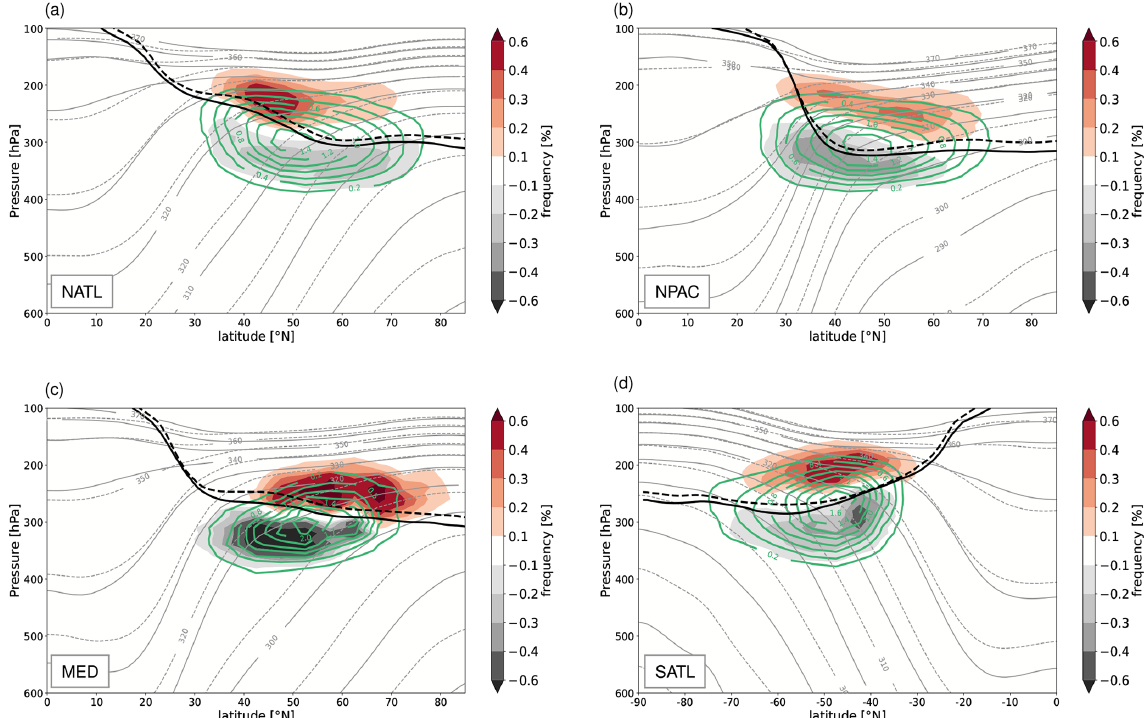
Figure 11. The 50-year mean potential temperature (grey lines) and potential vorticity (2pvu isolines; black lines), zonally averaged over the four target regions (a) NATL, (b) NPAC, (c) MED, and (d) SATL. For both fields, dashed lines correspond to RCP8.5 and solid lines to HIST. Solid green lines show the normalized frequency (bin size 5 ◦ , 25hPa) of the WCB air parcels at the end of their ascent for HIST (outermost line for 0.2% with an increment of 0.2% for NATL, NPAC, and SATL and 0.3% for MED). The corresponding effect of climate change on the normalized WCB frequency, RCP8.5 − HIST, is shown in colour shading. All panels are for winter in the corresponding hemisphere,